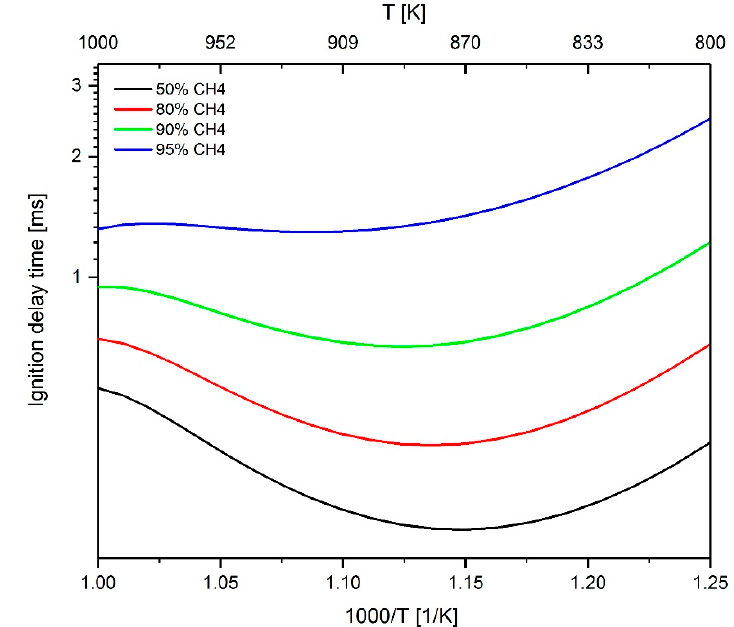
Figure 18. Increase of the IDT by adding methane to the n -heptane–air mixture simulated at φ = 1 and 60 bar.